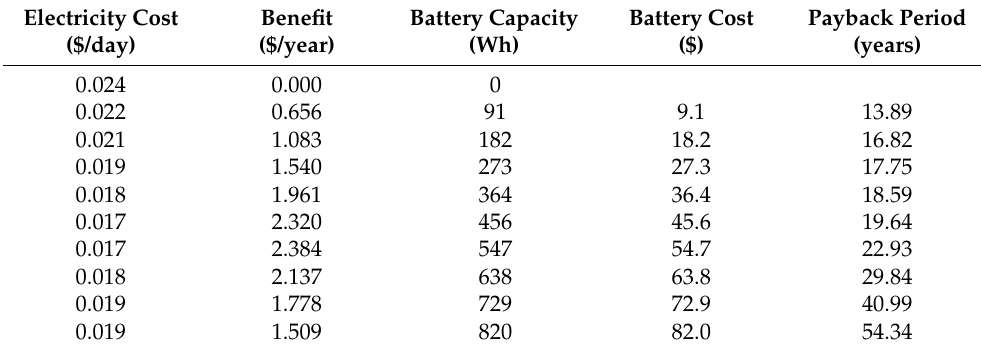
Table 6. Battery capacity analysis: refrigerator, Case